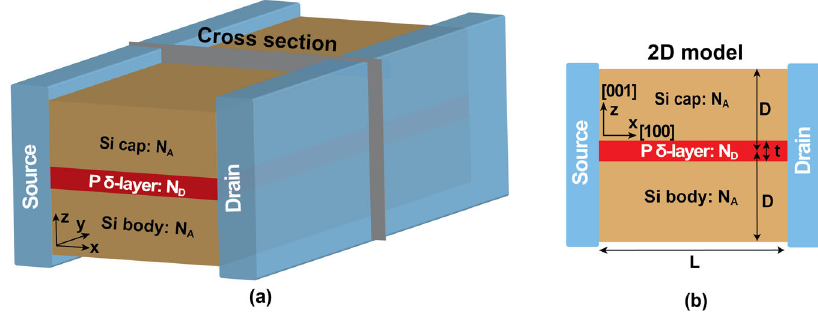
Fig. 1 Geometry of the δ -layer system and corresponding computational model. The Si:P δ -layer device shown in a consists of a source, drain, and channel. The channel is composed of a Si body, Si cap, and P δ -layer. The source and drain represent an extension of the channel to the in fi nity along the x - axis, with the same properties along the z -axis as the channel. The dimension of the device along the y -axis is in fi nite. The Si cap and Si body are doped with a doping density of acceptors of N A , whereas the P δ -layer is doped with a doping density of donors of N D . b the 2D computational model used in the simulations, which represents a cross-section of the xz-plane of the device (see panel ( a